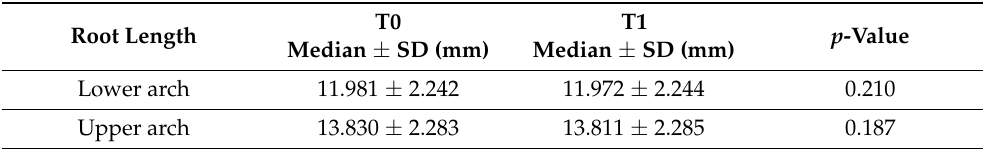
Table 5. Root length at T0 and T1 for maxillary and mandibular teeth.